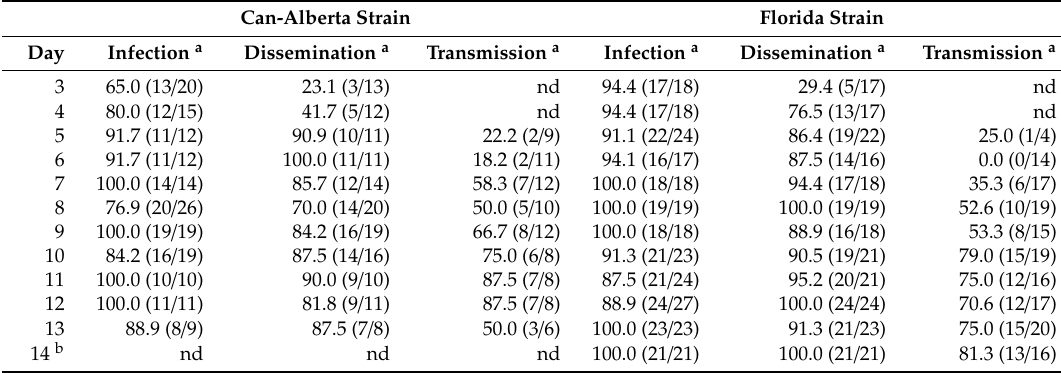
Table 1. Daily infection, dissemination, and transmission percentages (capillary tube and honey card methods combined) for the Can-Alberta strain and the Florida strain of EHDV-2 in Culicoides sonorensis . The number that tested positive over the total number assayed is included in parenthesis. Can-Alberta